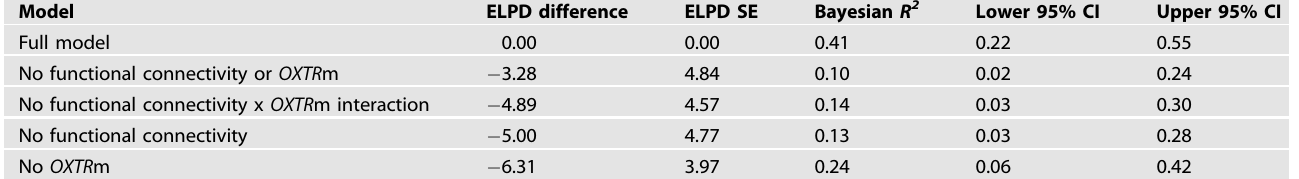
Fig. 2 Individuals with increased methylation of OXTR show greater right amygdala – mPFC structural connectivity. A Visualization of total child cohort axonal connections between right amygdala (light blue) and the left frontal cortex ROI (red) while also displaying the location of the signi fi cant cluster determined from the fMRI analysis seeded in the right amygdala (yellow). Connections were visualized from the whole- brain tractograms of all subjects in the study and streamlines were colored based on the OXTR m of the associated subject, with darker blue signifying lower OXTR m and lighter green signifying higher OXTR m. B Number of streamlines are plotted against the percent OXTR m for each participant ( n = 51). Gray shading indicates 95% con fi dence interval around the best- fi t line. Table 1. Leave-one-out model comparison results suggest the full model, including amygdala – mPFC functional connectivity and OXTR m fi ts